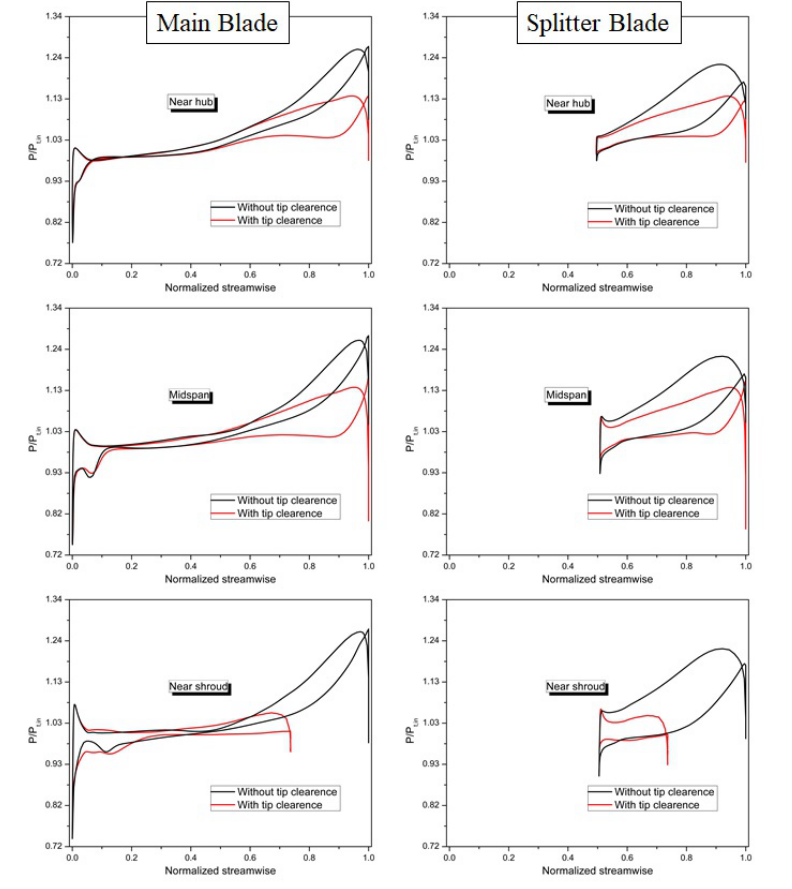
Figure 9. Blade pressure loading for impeller without tip clearance and with tip clearance at a mass flow rate of 4